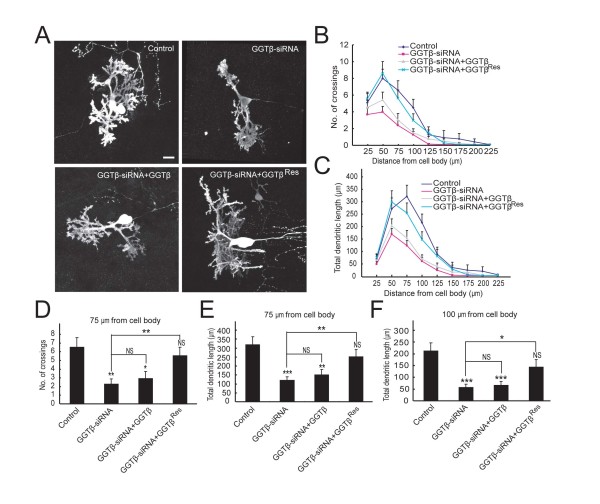
Rescue effect of siRNA-resistant form of GGTβ. A) Representative images of Purkinje cells after transfection with pSUPER (control), pSUPER-GGTβ-siRNA, or GGTβ-siRNA together with HA-GGTβ or HA-GGTβRes. B) Quantification for the number of crossings. C) Quantification for total dendritic length between neighboring circles. D) Number of crossings at the circle with radius of 75 μm was quantitatively analyzed. E, F) Total dendritic length between neighboring circles at the interval of 25 μm (between 50 and 75 μm or between 75 and 100 μm). Data are shown as means ± SEM (n = 12 for control; n = 17 for GGT-siRNA; n = 15 for GGT-siRNA plus HA-GGTβ; n = 19 for GGT-siRNA plus HA-GGTβRes). N.S. P > 0.05; *P < 0.05; **P < 0.01; ***P < 0.001. Student's t test. Scale bar = 20 μm.